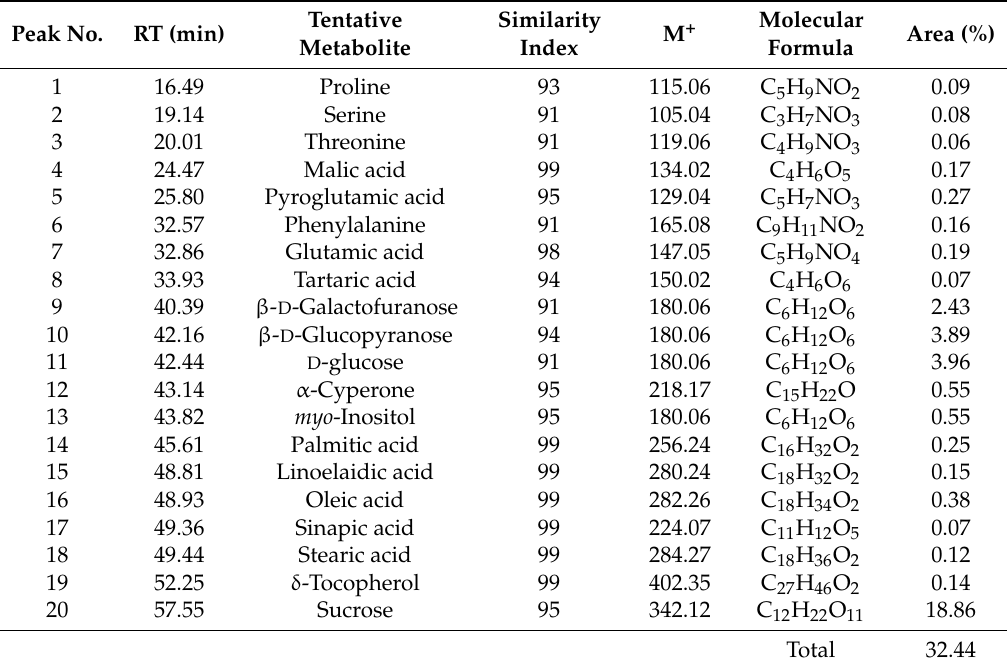
Metabolites identified in the D. indum seed methanol fraction (SMF) through Gas Chromatography-Mass Spectrometry (GC-MS) analysis. Peak